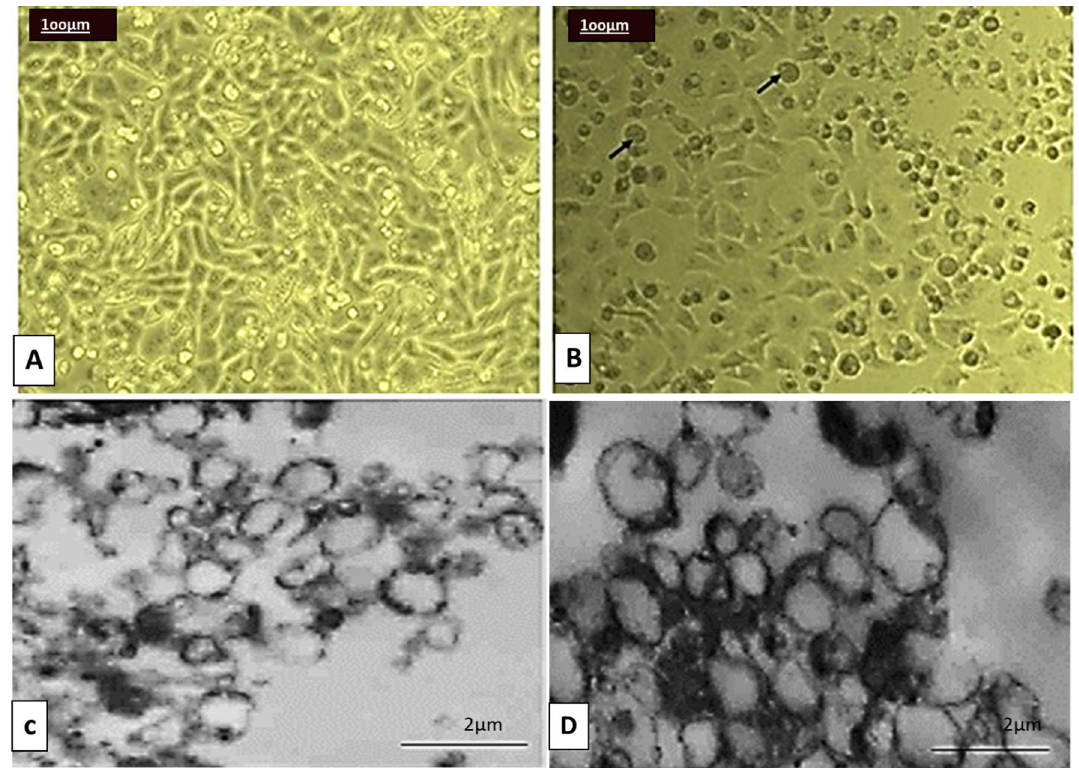
Fig. 1 A untreated CRC cells; B CRC cells treated with G-CSF; showing decrease in the number of CRC cells, black arrows indicate cell rounding and detachment which are signs of apoptosis, C exosomes from untreated CRC cells, D exosomes from G-CSF treated CRC cells by TEM showing their cup shaped morphology and size (100 nm), scale bar (2